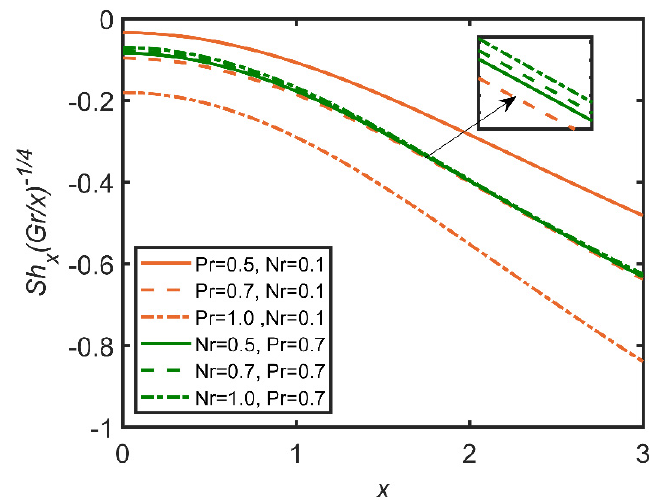
Figure 11. Comparison for Sherwood number against x.